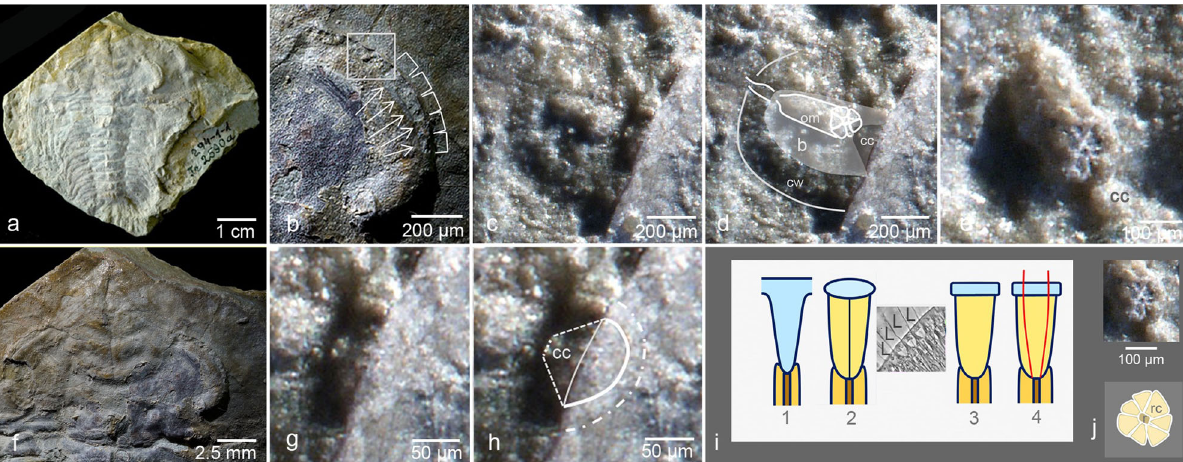
Fig. 1 Apposition compound eye and its fossil record. a Trilobite Schmidtiellus reetae Bergström, 1973, (deposited at the Institute of Geology at Tallinn University of Technology, Estonia, under repository number GIT 294-1., holotype), Lower Cambrian, Estonia, and its compound eye. b Abraded part of the right eye. Note the rectangular sequential elements ‘ baskets ’ containing the ommatidia. c , d ‘ Basket ’ with ommatidium. e Ommatidium in cross section, showing clearly relics of receptor cells, a central rhabdom and crsytalline cone. f head of S. reetae (a). g , h Top part of c . Crystalline cone and thin cuticle above the ommatidia. i Principles of optics in arthropods. 1 Exocone of Xiphosura (Chelicaerata, Limulus ), 2 insects, insert: ommatidia of the honey bee ( Apis mellifera L.) with a thick, effective cuticular lens in a histological section. Note the crystalline cones below the lenses., 3, 4 crustacean, with ray path in an index gradient lens. j cross-section and schematic drawing of the ommatidium in S. reetae . b ‘ basket ’ , cc crystalline cone, ce cellular wall of the ‘ basket ’ , om ommatidium, L lens, r rhabdom, rc receptor cell; green: lens, pink: crystalline cone, yellow: receptor cell, brown: